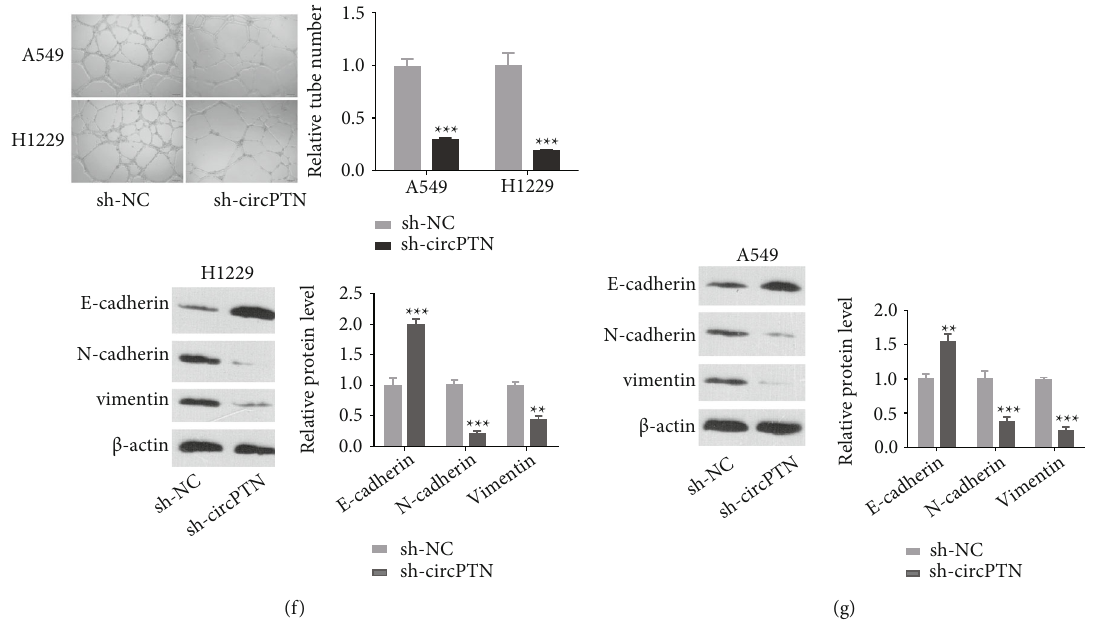
Figure 2: Knockdown of circPTN inhibits the proliferation, migration, invasion, and tube formation ability of NSCLC cells. (a) Knockdown e ffi ciency of sh-circTPN was detected by qRT-PCR. (b) CCK-8 proliferation assay in A549 and H1229 cells transfected with sh-NC or sh- circTPN (c) EdU incorporation assay in A549 and H1229 cells transfected with sh-NC or sh-circTPN. (d) Transwell-migration assay in A549 and H1229 cells transfected with sh-NC or sh-circTPN. (e) Transwell-invasion assay in A549 and H1229 cells transfected with sh- NC or sh-circTPN. (f) Tube formation assay in in A549 and H1229 cells transfected with sh-NC or sh-circTPN. (g) WB was performed to detect EMT-related proteins (E-cadherin, N-cadherin, and vimentin) in A549 and H1229 cells transfected with sh-NC or